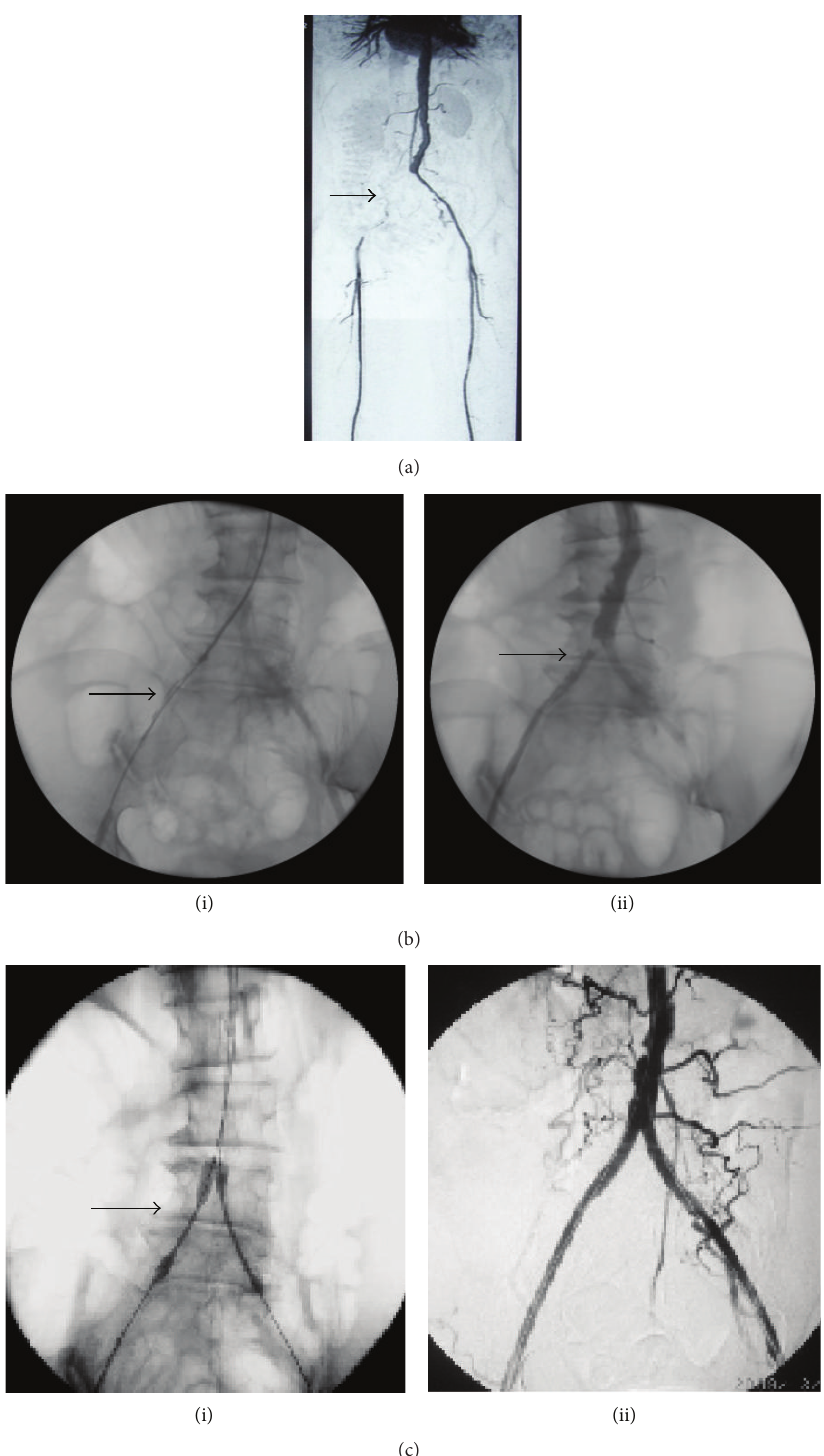
Figure 1: Case (1): stenting for a female PAD patient of 69 years. (a) CTA showed severe right iliac artery occlusive lesions about 12 cm (arrow). (b) (i) Thrombolysis by catheter (arrow). (b) (ii) Two days later, angiogram showed right iliac artery occlusive lesion changed from TASC II D to B (arrows). (c) (i) Endovascular angioplasty by Kissing-stenting (arrow). (c) (ii) Excellent result at right iliac